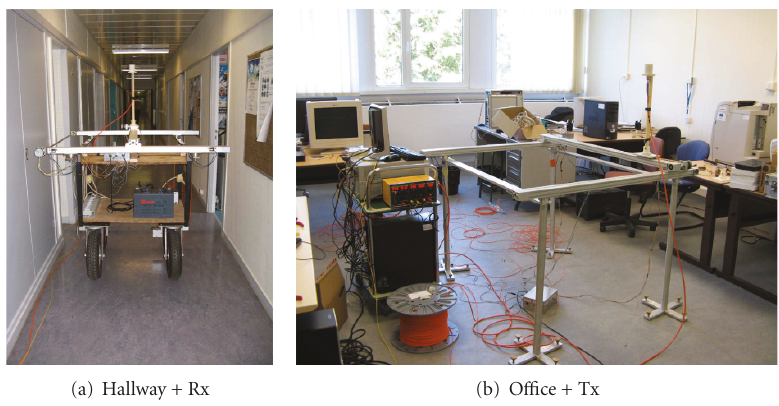
Figure 3: Photos of the measurement environment including the virtual